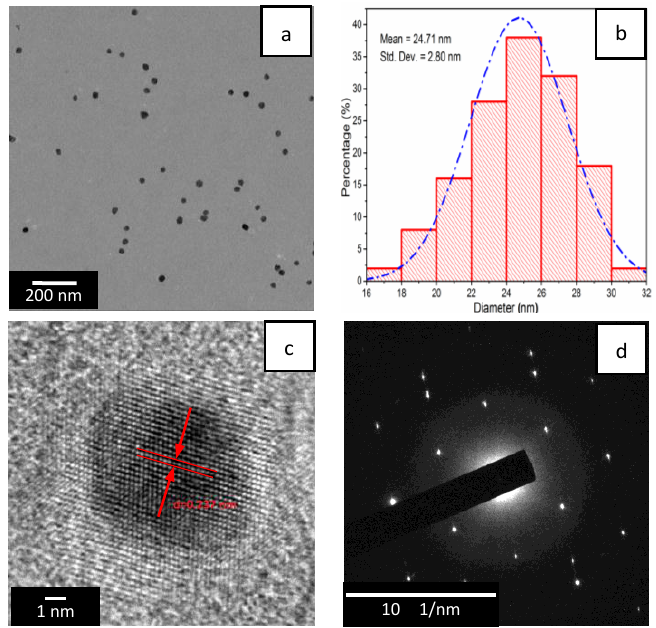
Figure 8. ( a ) Transmission electron microscopy (TEM) image of QCMC-Ag; ( b ) size distribution histogram of Ag NPs; ( c ) inverse fast Fourier transform (IFFT) image and ( d ) selected area electron diffraction (SAED) pattern.